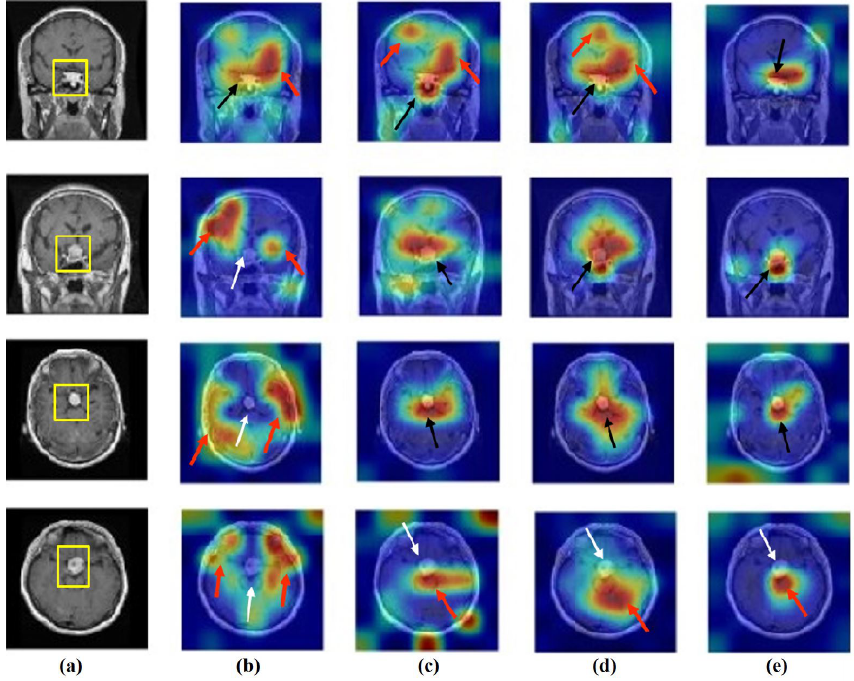
Figure 18. Visualisation of deep features for class pituitary tumours of brain tumour test set images obtained by each model: ( a ) original image, ( b ) ResNet-50 pre-trained network, ( c ) DeTraC, ( d ) 4S-DT , and ( e ) XDecompo